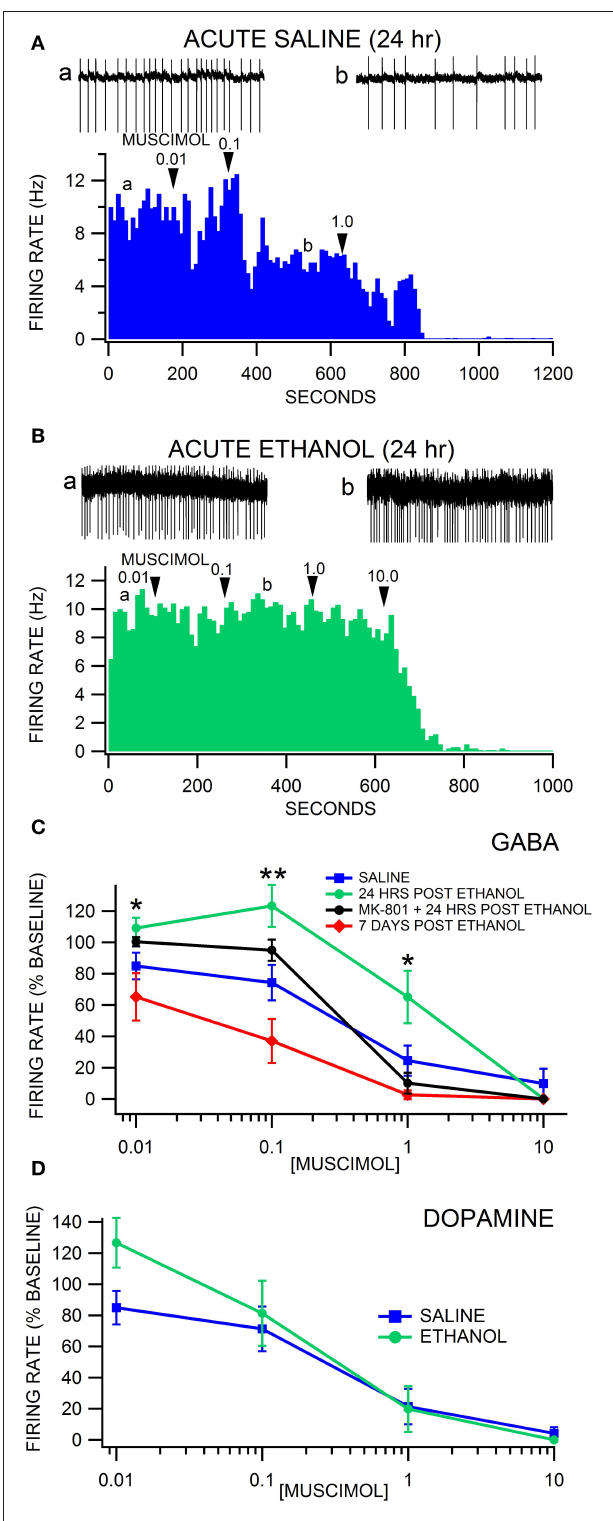
FIGURE 2 | Decreased sensitivity of VTA GABA neurons to muscimol 24hafterasingleinjectionofethanol. (A) Theratemetershowsthefiringrateofa